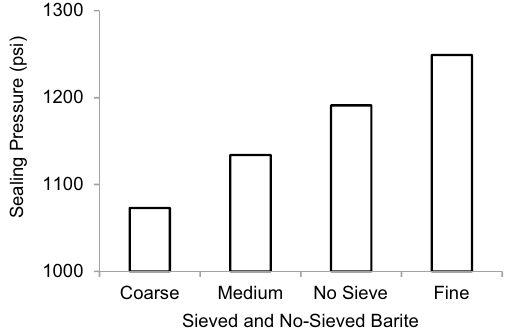
Fig. 4 Effect of increasing the drilling fluid density on the sealing